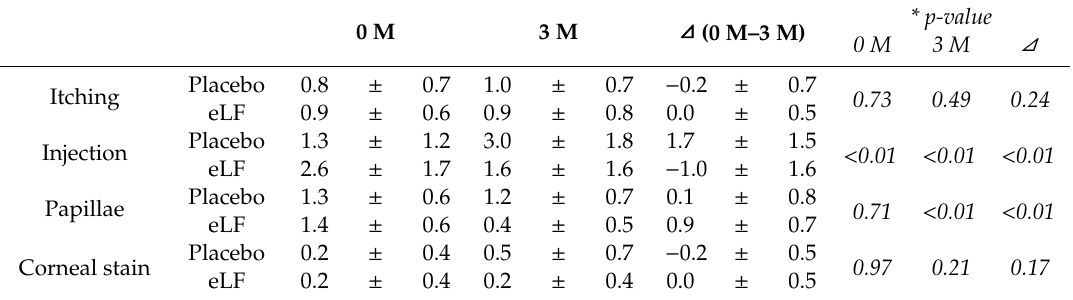
weeks). 185 weeks). 185